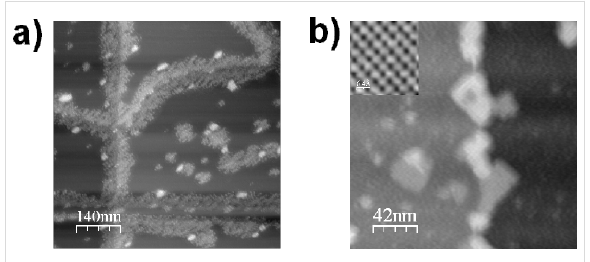
Figure 2: 0.2 ML of MSPS evaporated onto KCl. (a) displays the NC-AFM topography after deposition at RT ( Δ f = − 59 Hz, A 0 = 7 nm), (b) shows the surface after annealing to 110 °C for 15 min ( Δ f = − 40 Hz, A 0 = 7 nm). The substrate orientation is shown in the inset.